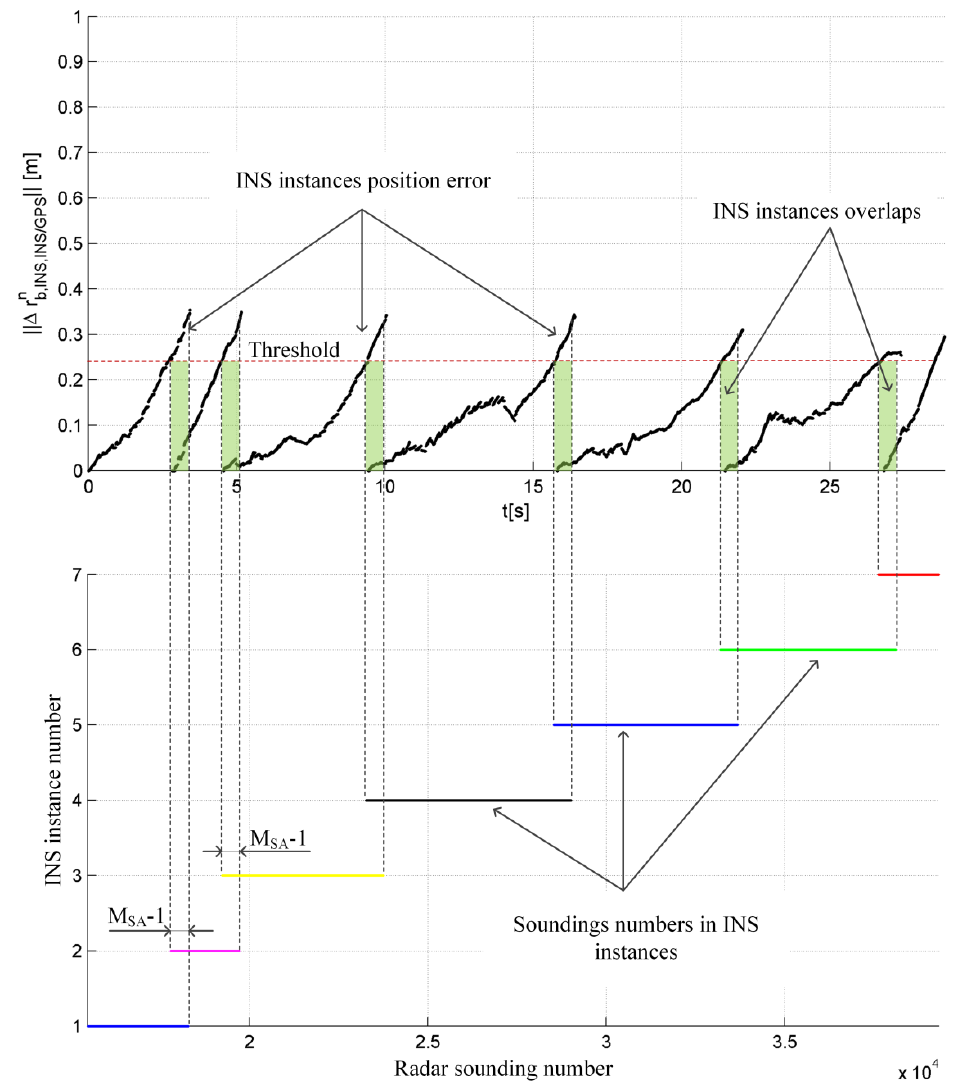
Figure 9. Navigation corrections data overlap.